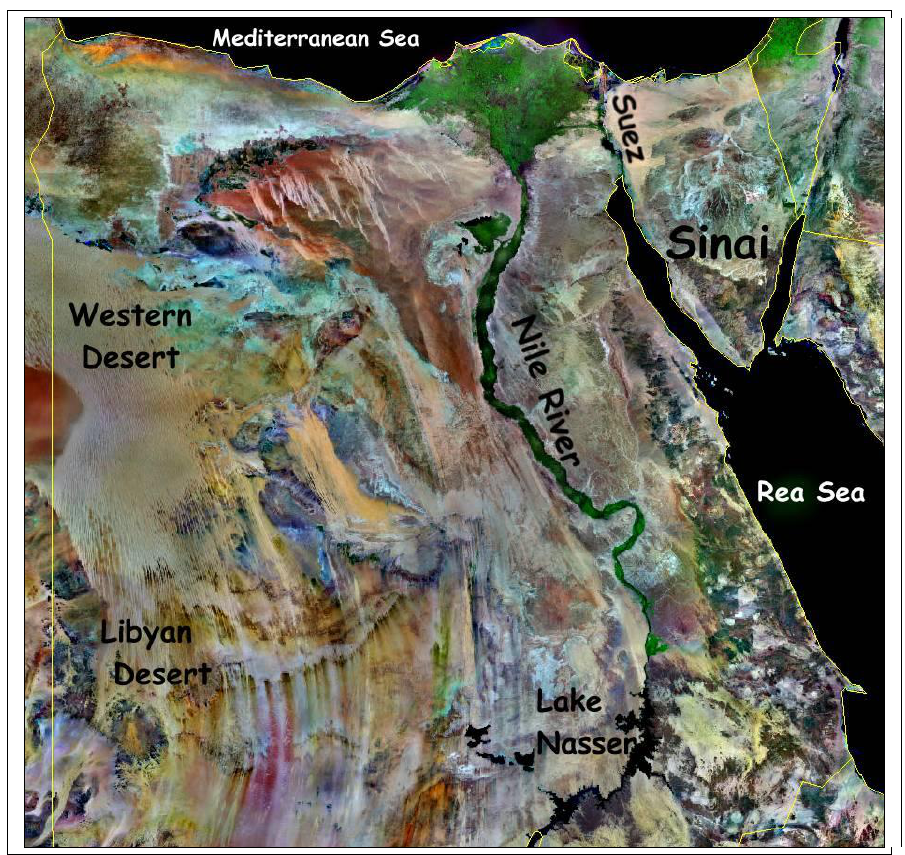
Figure 11. Orthorectified Landsat Thematic Mapper Mosaic [16], Band 7 (mid-infrared light) is displayed as red, Band 4 (near-infrared light) is displayed as green, Band 2 (visible green light) is displayed as